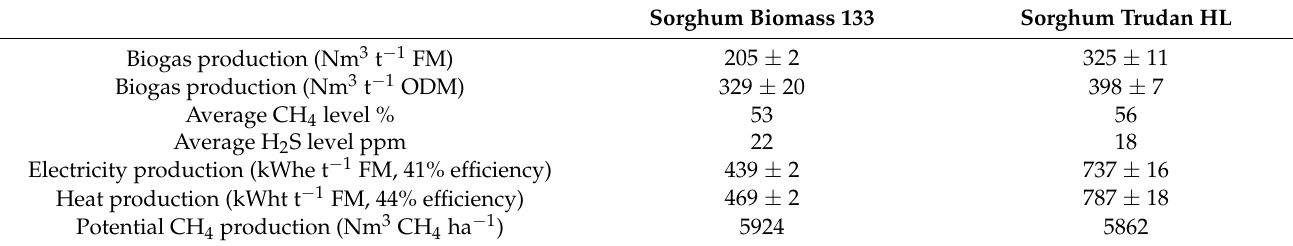
Table 4. Average biogas production (n = 2, ± SD), biogas quality, and energy production for the two cultivars of sorghum cultivated on the area 2. Sorghum Biomass 133 Sorghum Trudan